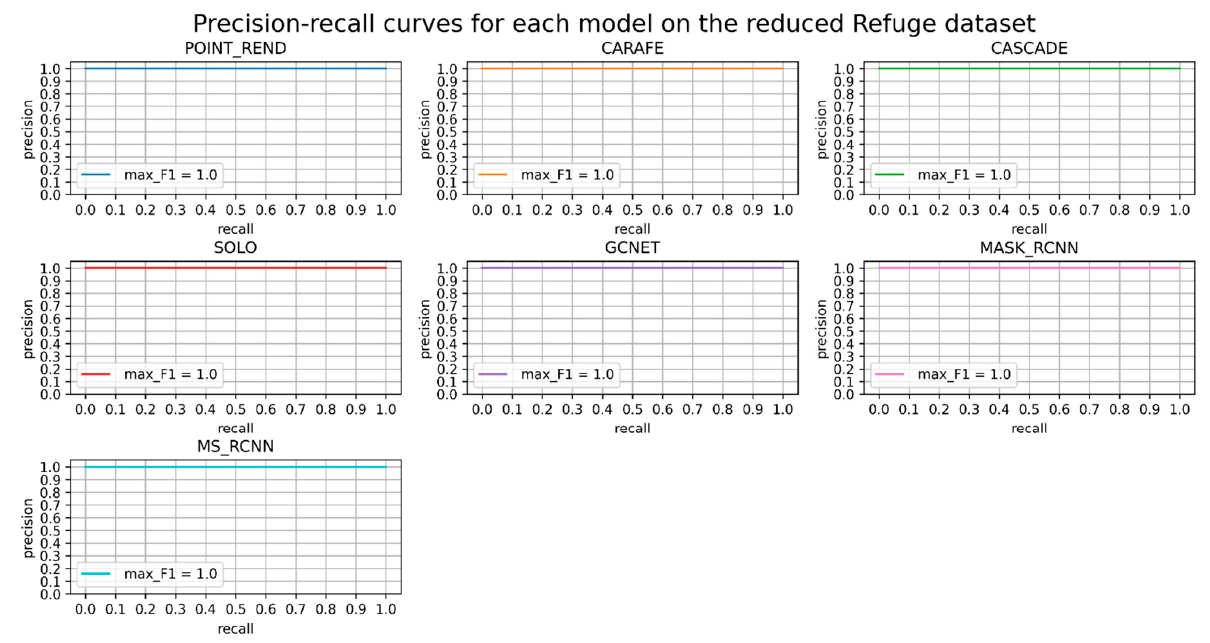
Figure 5. Precision-recall curve for each model on the reduced Refuge dataset. F1 score is provided for each model.